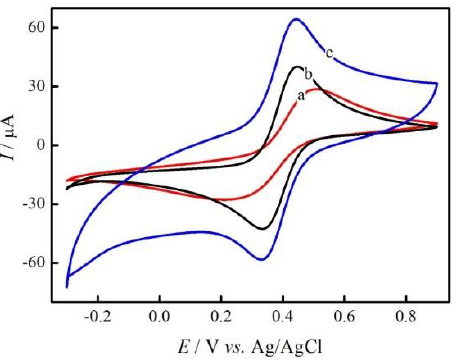
Figure 3. CV scans of the electrodes: (a) GC/GO, (b) GC/rGO and (c) GC/rGO-AuNPs in 0.1 mol L −1 H 2 SO 4 containing 5.0 mmol L −1 of the redox couple [Fe(CN6)] 3−/4− with a scan rate of 50 mV s −1 .